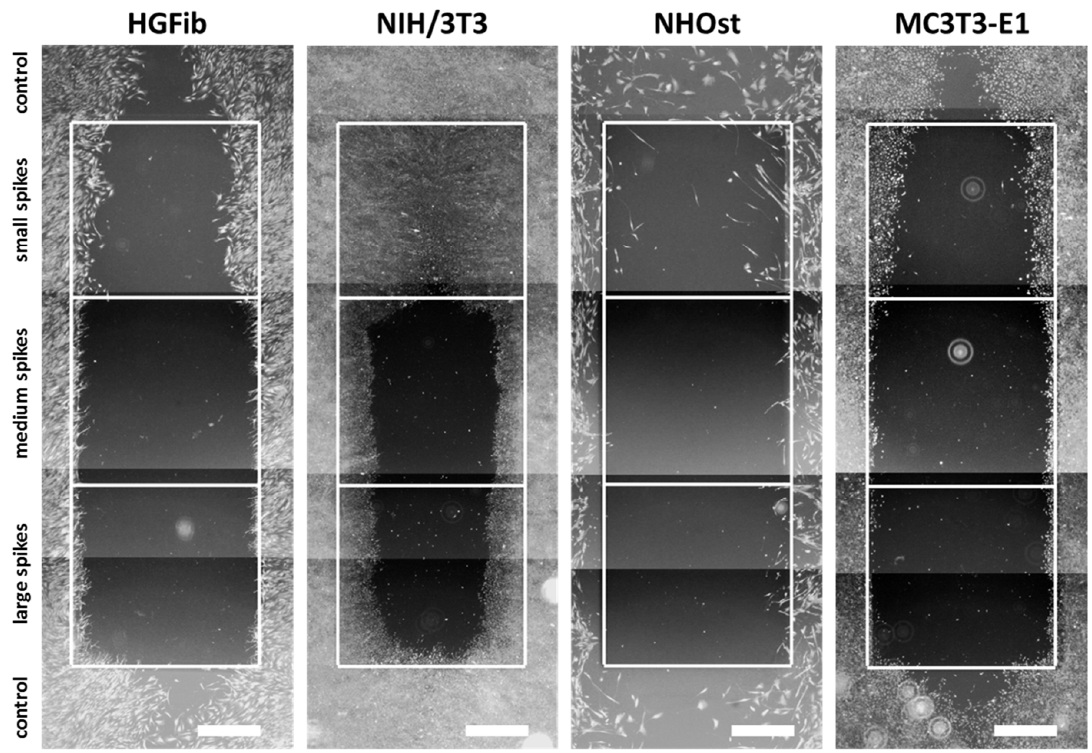
Figure 4. Cellular migration on spike topographies after 7 d. HGFib, NIH/3T3, NHOst, and MC3T3- Figure 4. Cellularmigrationonspiketopographiesafter7days. HGFib, NIH / 3T3, NHOst, andMC3T3-E1 E1 were cultivated for 7 d and stained with Calcein-AM. Scale = 1 mm. were cultivated for 7 days and stained with Calcein-AM. Scale = 1